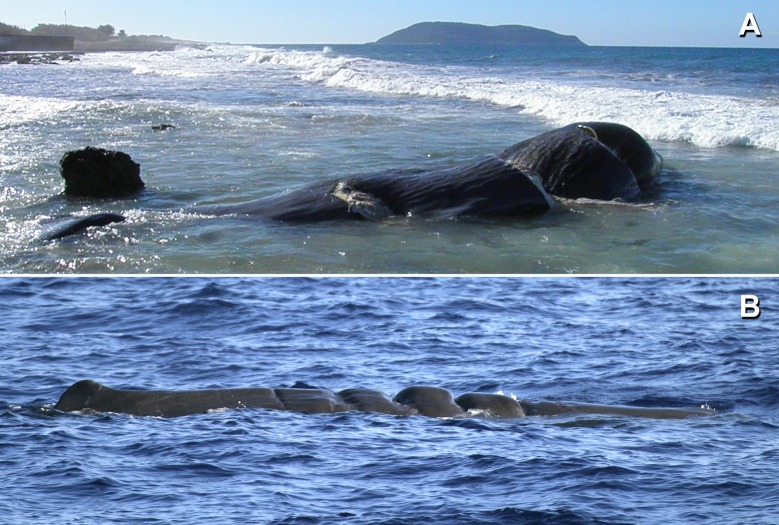
Propeller marks on stranded and free ranging sperm whales along the Hellenic Trench.(A) One of the recent cases of ship strike with a sperm whale that occurred along the Hellenic Trench on 15 February 2014, 25 km north of Pylos in SW Peloponnese. Three big cuts from a large propeller were apparent on this very freshly dead whale. (B) One of the live sperm whales photographed in 2004 along the Hellenic trench in SW Crete (catalogued with the name “Ifaistos”) bearing clear and deep marks from a ship propeller between the head and the dorsal fin. Photo credits (A): Filiatranet, (B): Chris Johnson.